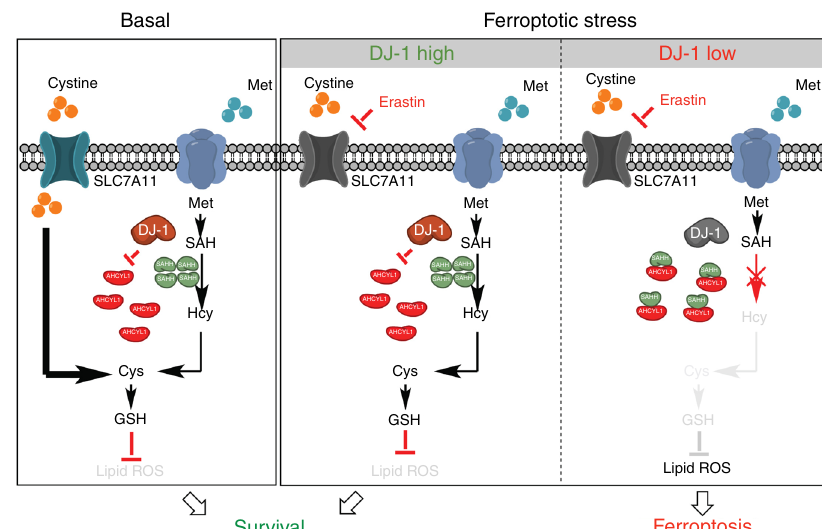
Fig. 8 Scheme for the effect of DJ-1 on negatively regulating ferroptosis. There are two routes to generate the intracellular cysteine in cells: one is the cystine import though SLC7A11 and the other one is the transsulfuration pathway. Under basal conditions, the cystine import plays the dominate role in the GSH precursor cysteine generation. When the cystine import is blocked by erastin, the DJ-1 preserved transsulfuration pathway still could provide essential cysteine synthesis (refer to DJ-1 high with ferroptotic stress). DJ-1 depletion can markedly inhibit GSH levels only when the cystine import is blocked (refer to DJ-1 low with ferroptotic stress). The DJ-1 KD distinctly decreases Hcy levels by impairing SAHH activity via enhancing its interaction with AHCYL1. Decreased level of Hcy subsequently causes the depletion of GSH and eventually enhances ferroptotic cell